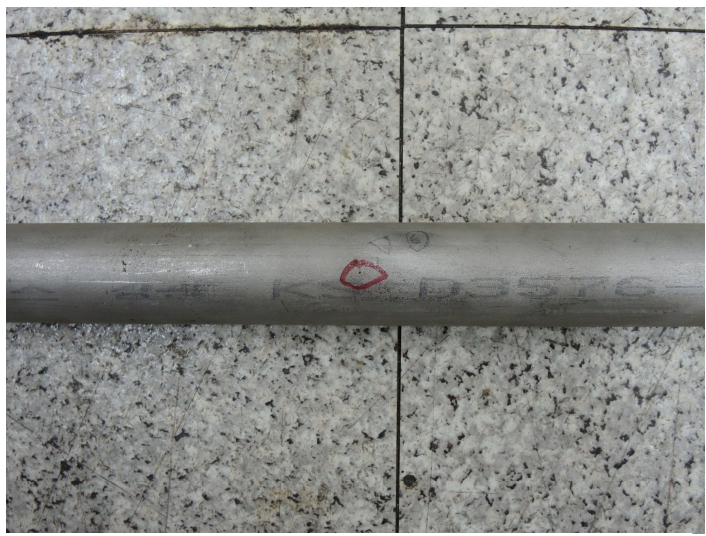
Figure 6. A simulated leak orifice of the